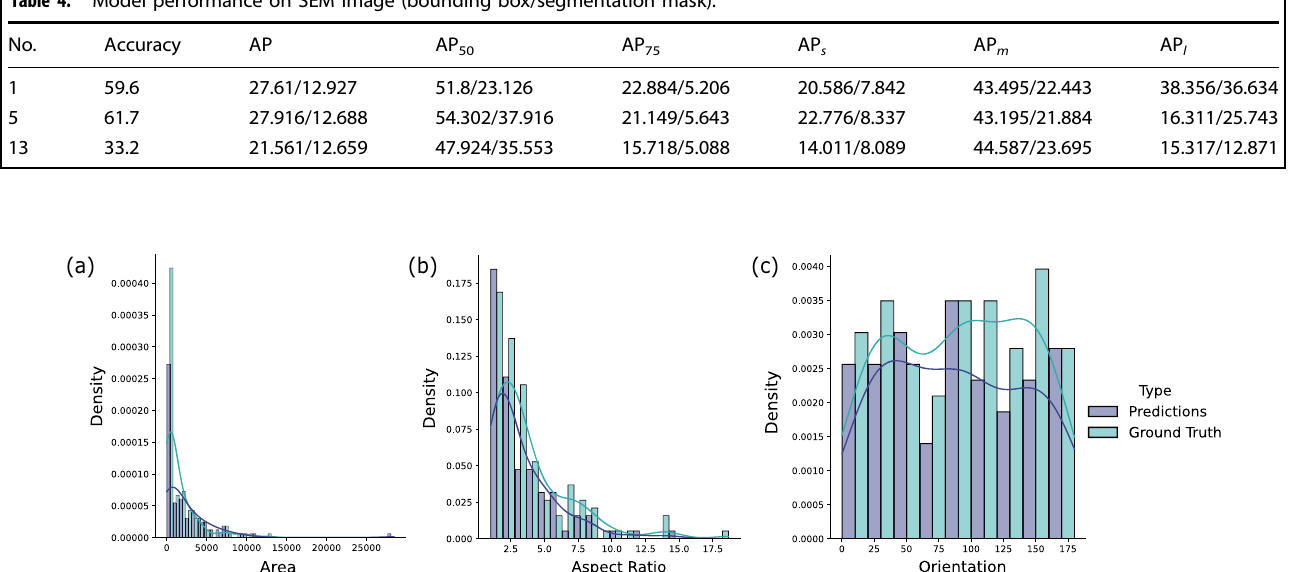
Fig. 9 Particle statistics from the SEM image. Histograms and KDE curves are illustrated as a function of area, aspect ratio, and orientation in a – c , respectively. The statistical results show good qualitative agreement. The main discrepancy exists for smaller FN nanowires missed by the model, thus leading to higher-density estimates in the ground truth (manual annotation) in the respective number ranges, e.g. the peak in area size